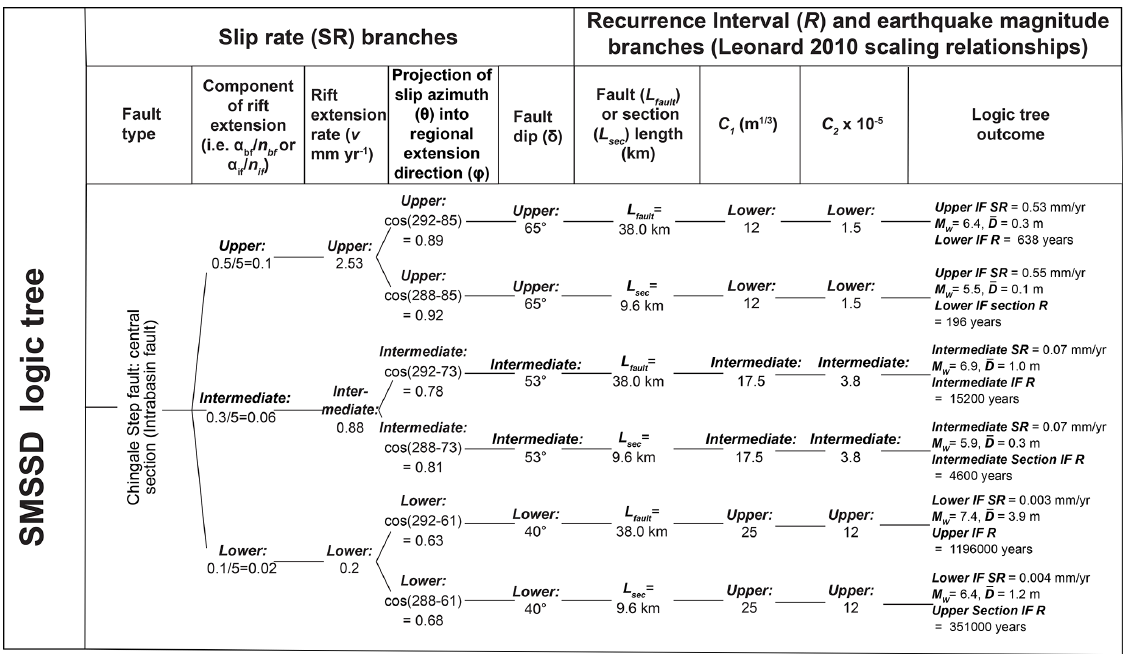
Figure 7. Example of the calculations in the SMSSD logic tree (Fig. 6), performed for the central section of the Chingale Step Fault (Fig. 4b). This is an intra-basin fault in the Zomba Graben, where the number of intra-basin faults ( n if ) is five. A multiparameter sensitivity analysis for these calculations is documented in Appendix A. Table 4. Range of selected numeric attributes across all faults and sections in the SMSSD. To demonstrate how calculated attributes vary across different faults in the SMSSD, as opposed to variation from the set of parameters used to calculate them, the values shown are for the intermediate branches in the SMSSD logic tree (Fig.